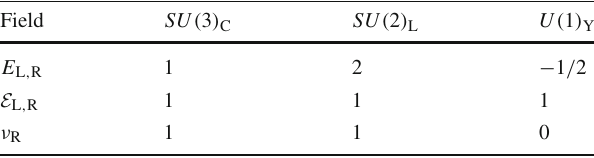
Table 1 Quantum numbers of the new exotic fermions. We adopt the notation of E L , R being an SU ( 2 ) doublet, while E L , R is a singlet, and ν R is the new right-handed neutrino Field